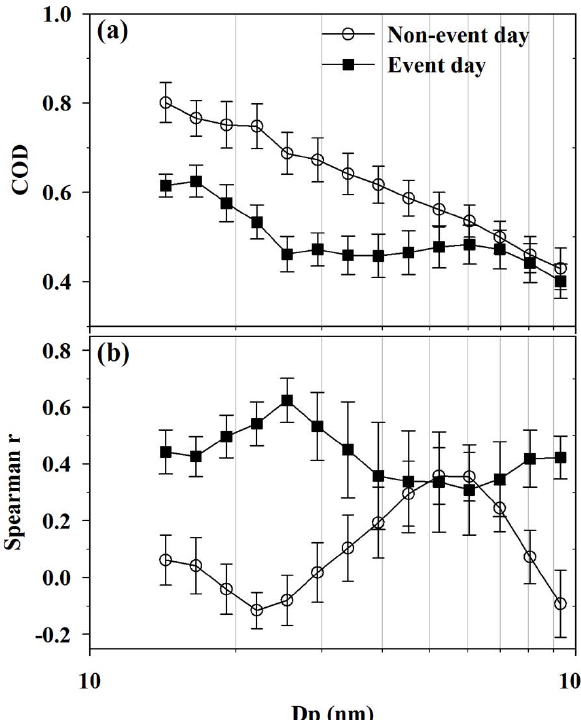
Fig. 11. Average variation of CODs (a) and Spearman correlation coefficients (b) for the five sites during the non-event day (26 June) and the nucleation event day (2